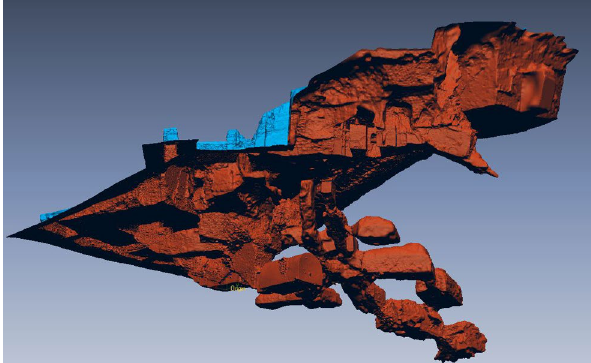
Figure 9 . Section of